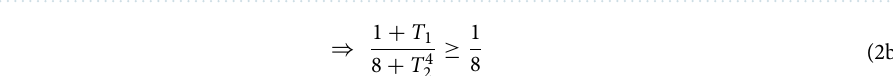
µ , Q a P a ( b ) Extreme (Maximum and minimum) values CE FS FS (cid:31) (cid:30)